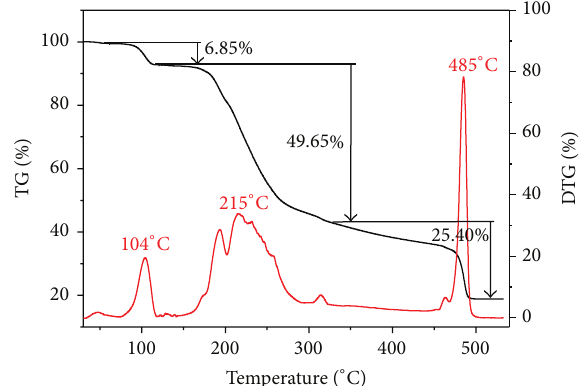
Figure 12: TG-DTG curves of complex 3